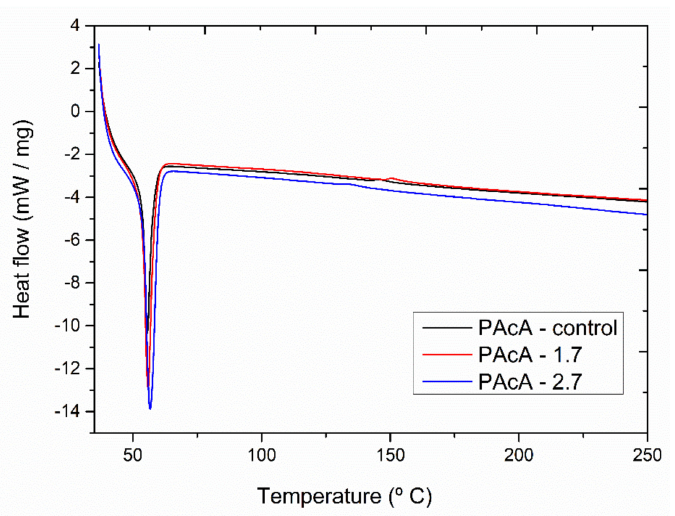
Figure 5. DSC (second heat) analysis of andiroba oil and PCL films in acetic acid (PAcA-control, PAcA-1.7, PAcA-2.7).